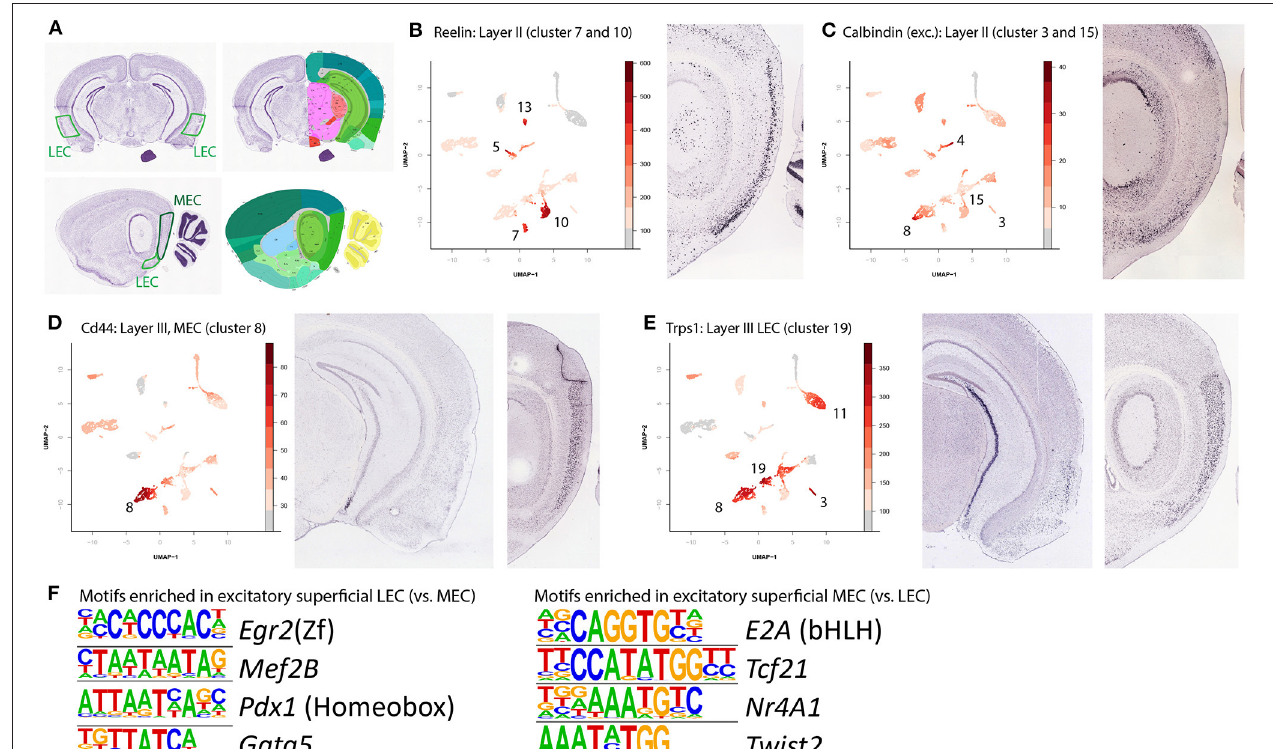
FIGURE 3 | Identification of superficial layer excitatory neurons and enriched motifs. (A) Nissl stained and reference images of a mouse brain. Used to identify gene expression in the two different subregions of the EC. Left panels are coronal (3.1mm posterior to bregma) right panels are sagittal (3.3mm lateral from the midline). Image taken from Lein et al. (2007). (B) Superficial neurons of the entorhinal cortex can be grouped into three broad categories: the reelin and calbindin expressing LII cells and the layer III cells. Here the Reelin expressing LII cells (clusters 7 and 10 for MEC and LEC respectively) are labeled by accessibility of the Reelin gene. Note that this gene is also expressed in various inhibitory neuron cell types. (C) Accessibility of the Calbindin gene labels the Calbindin positive cell types (clusters 3 and 15, for MEC and LEC respectively). Similar to Reelin , Calbindin is also expressed in various inhibitory cell types. (D) Accessibility of CD44 labels MEC LIII cells (cluster 8). (E) Accessibility of transcriptional repressor GATA binding 1 ( Trps1 ) but absence of accessibility of CD44 labels LEC LIII neurons (cluster 19). (F) Detection motifs enriched in excitatory, superficial cells of either the LEC or the MEC. The left sides show the enriched motifs, while the name behind denotes the corresponding best matching transcription